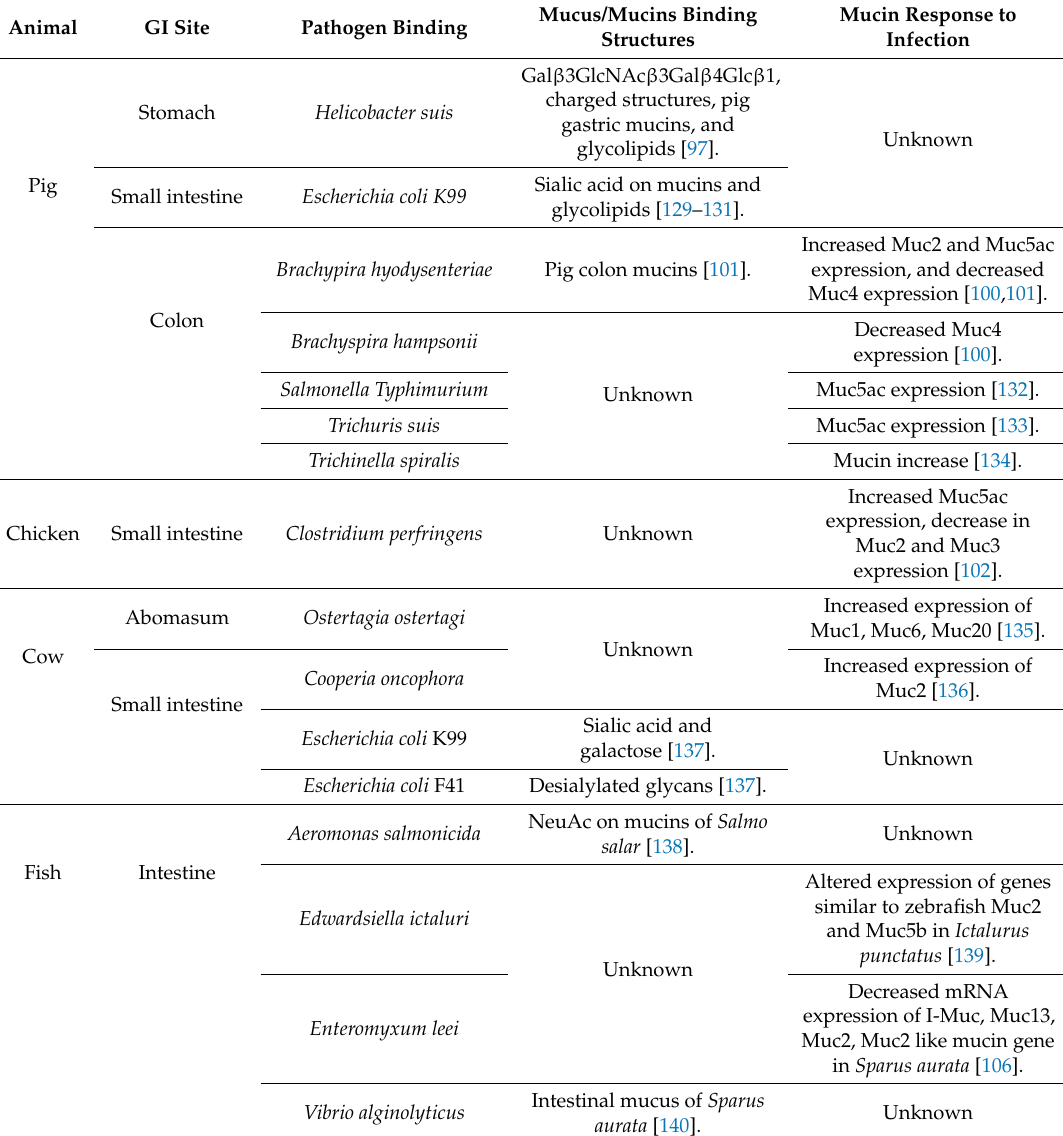
Table 2. Mucin binding pathogens and mucin response to infection in the gastrointestinal tract of farmed